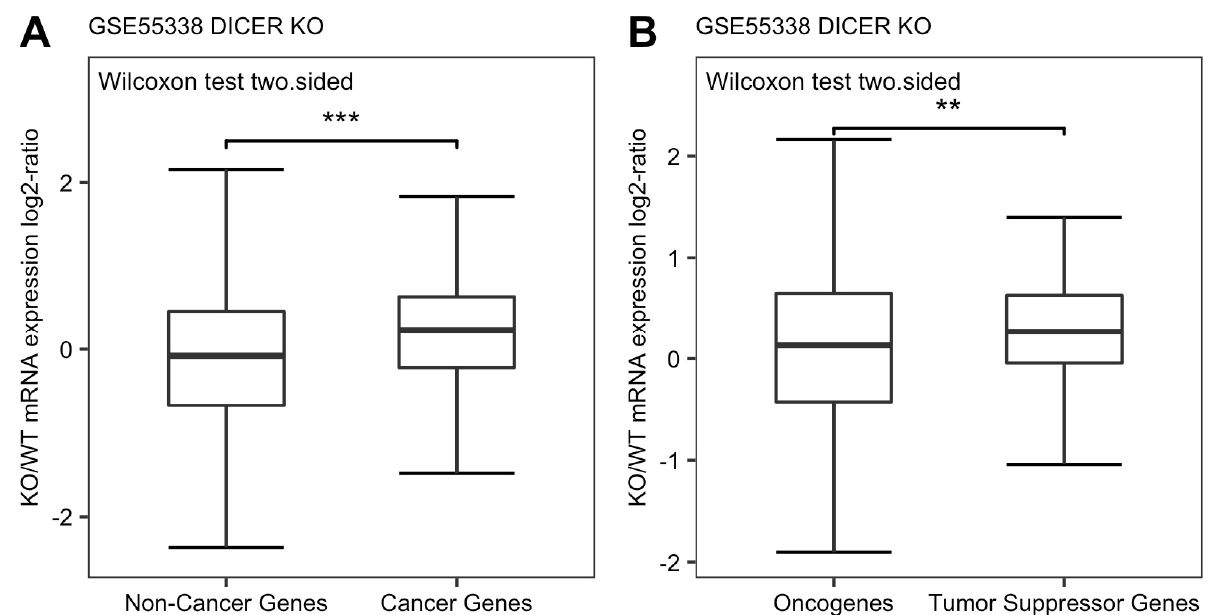
Figure 5. ( A ) Average expression changes of total protein-coding genes and 733 cancer genes in Dicer knockout mESCs ( p -value < 2.2 × 10 − 16 by two-sided Wilcoxon rank-sum test). ( B ) Average expression changes of 409 oncogenes and 324 TSGs in Dicer knockout mESCs ( p -value = 0.0094 by two-sided Wilcoxon rank-sum test). (“**” indicates p < 0.01, “***” indicates p < 0.001).